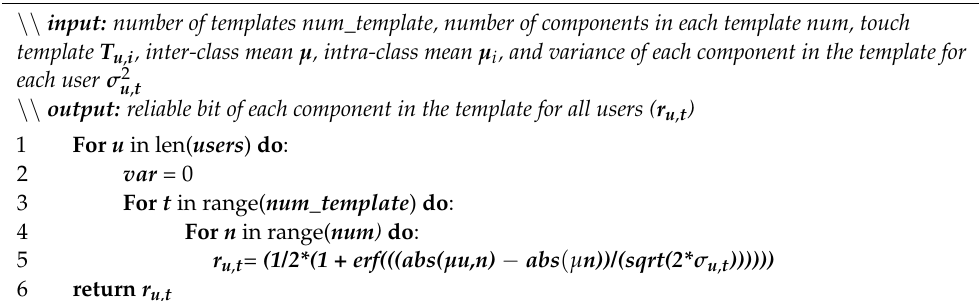
Algorithm 2 Calculate the Reliability of the i th Component in User Template T u , i